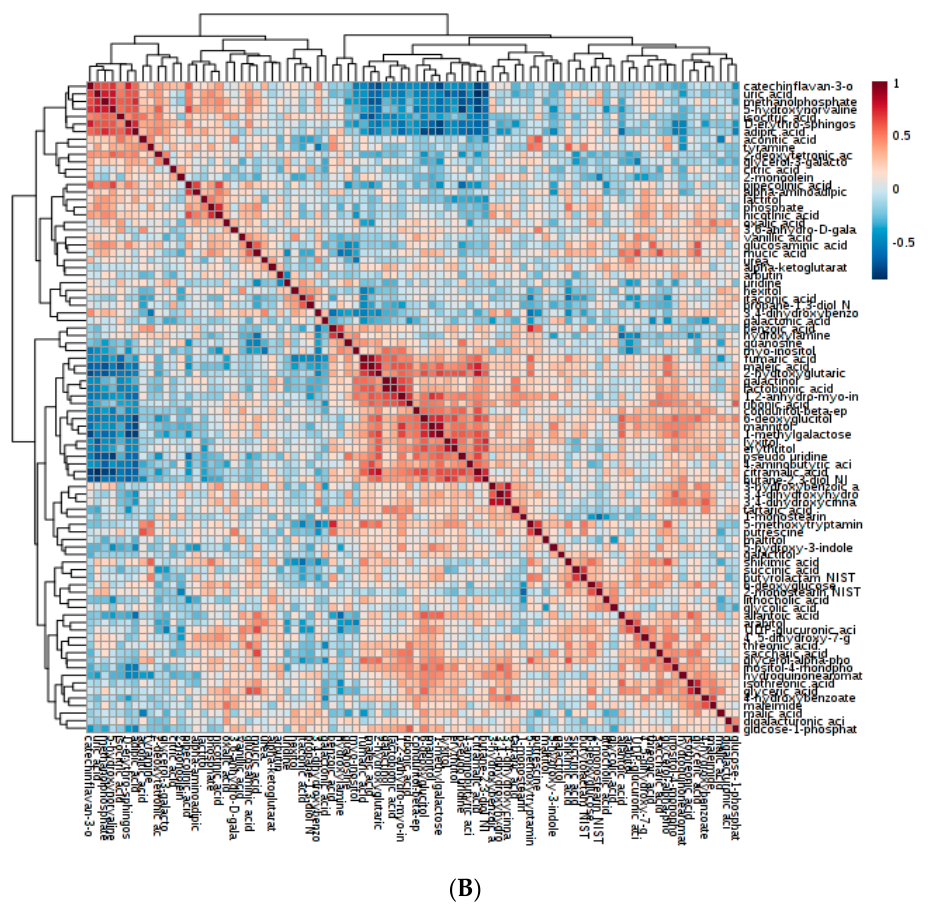
Figure 3. Heatmaps showing metabolite-to-metabolite correlation patterns. Two maps were developed for clarity ( A ). Heatmap showing the correlation among sugars, amino acids, polyphenols and fatty acids. ( B ). Heatmap showing the correlative pattern among organic acids, sugar derivatives, amines and vitamins. Table 2. Metabolites showing similar correlation pattern with sucrose and caffeine ( p < 0.05).